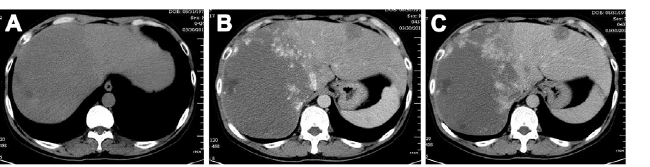
Fig 1. CT plain scan. An oval, low-density lesion with clear boundaries and central liquefactive necrosis (A). CT enhanced scan showing nodular enhancement at the edges of the lesion during the early arterial phase, and a higher density than the normal liver (B and C), appearing as the “ fast out, slow in ” sign.